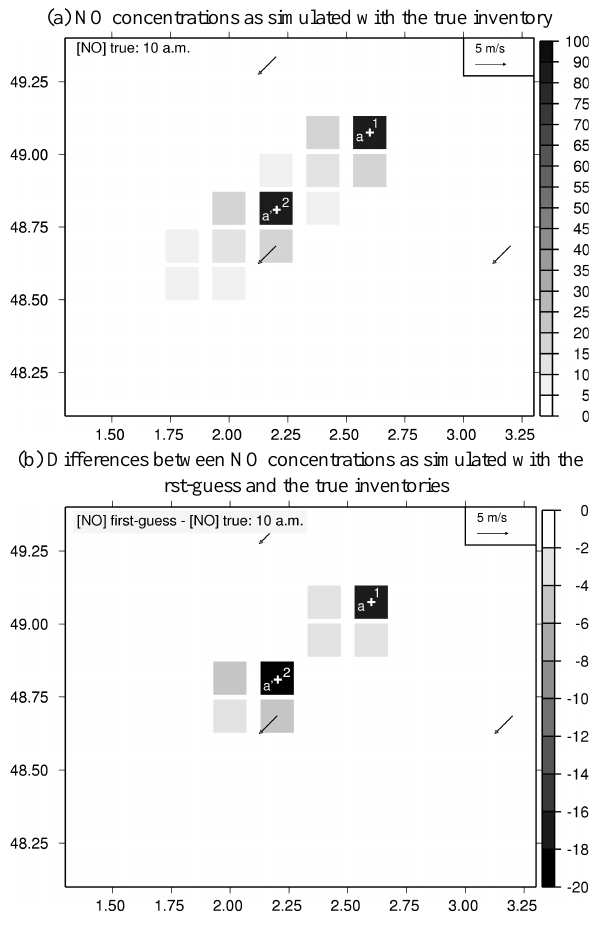
Fig. 2. NO surface concentrations and differences (ppb) for the formal test cases at 10 a.m.